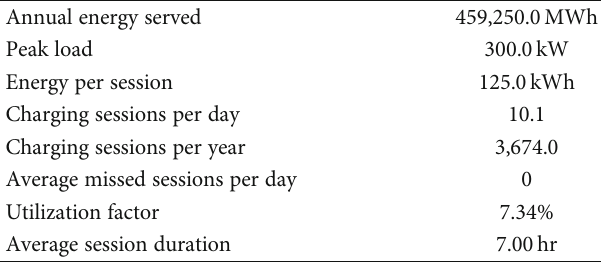
Figure 11: Daily electricity production over the year from the PV microgrid system. Table 6: The EV charging load (managed EV).